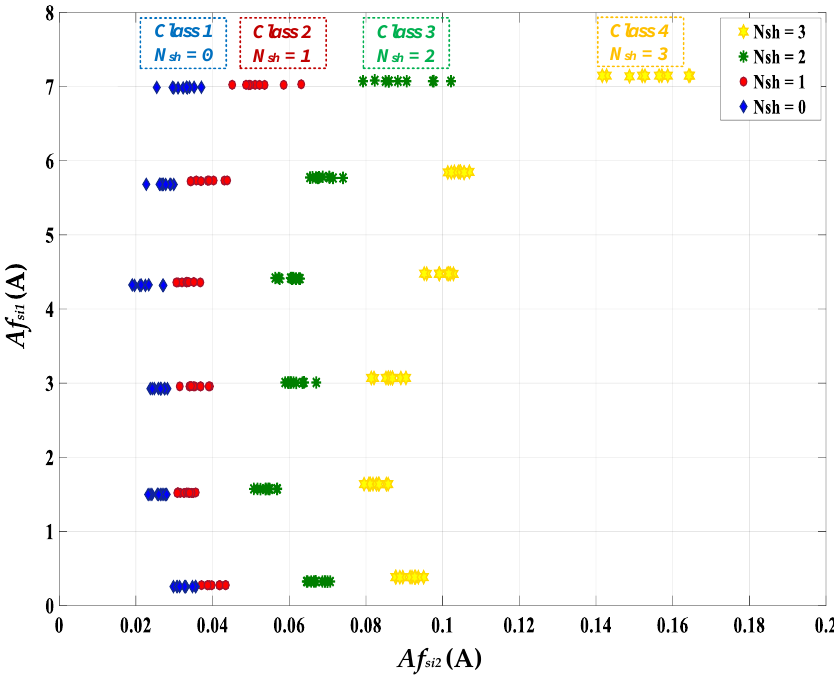
Figure 9. Distribution of the proposed fault features for different N sh .